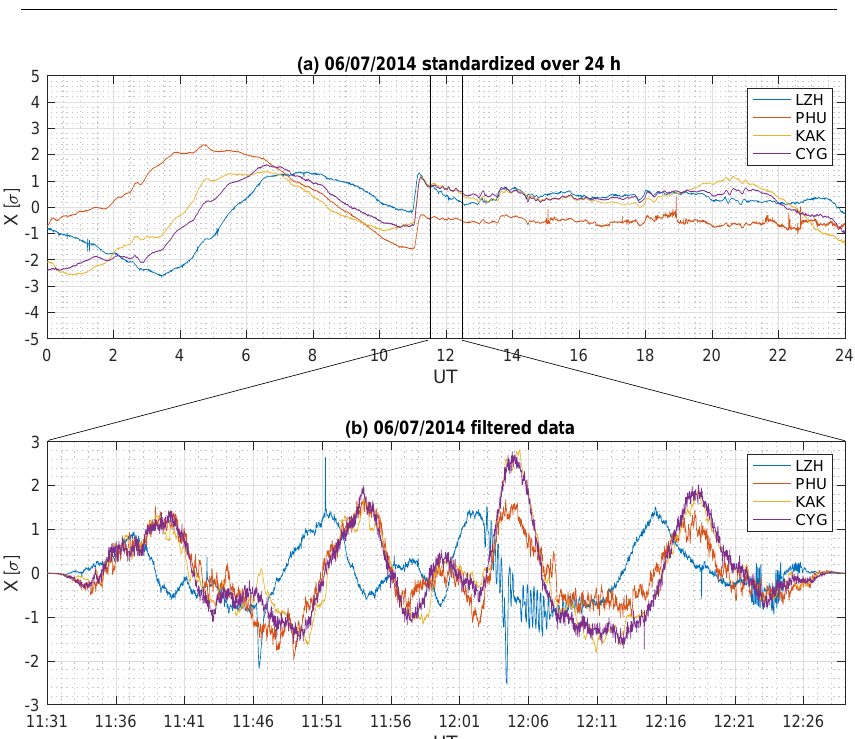
Figure 1. Time series of the standardized magnetic X component of LZH, PHU, KAK, and CYG observatories over 24h (a) and a zoom over 1h between 11:30 and 12:30UTC (b) , when magnetospheric activity is observed simultaneously at all observatories. The uncorrected data of LZH appear to anticipate this activity by about